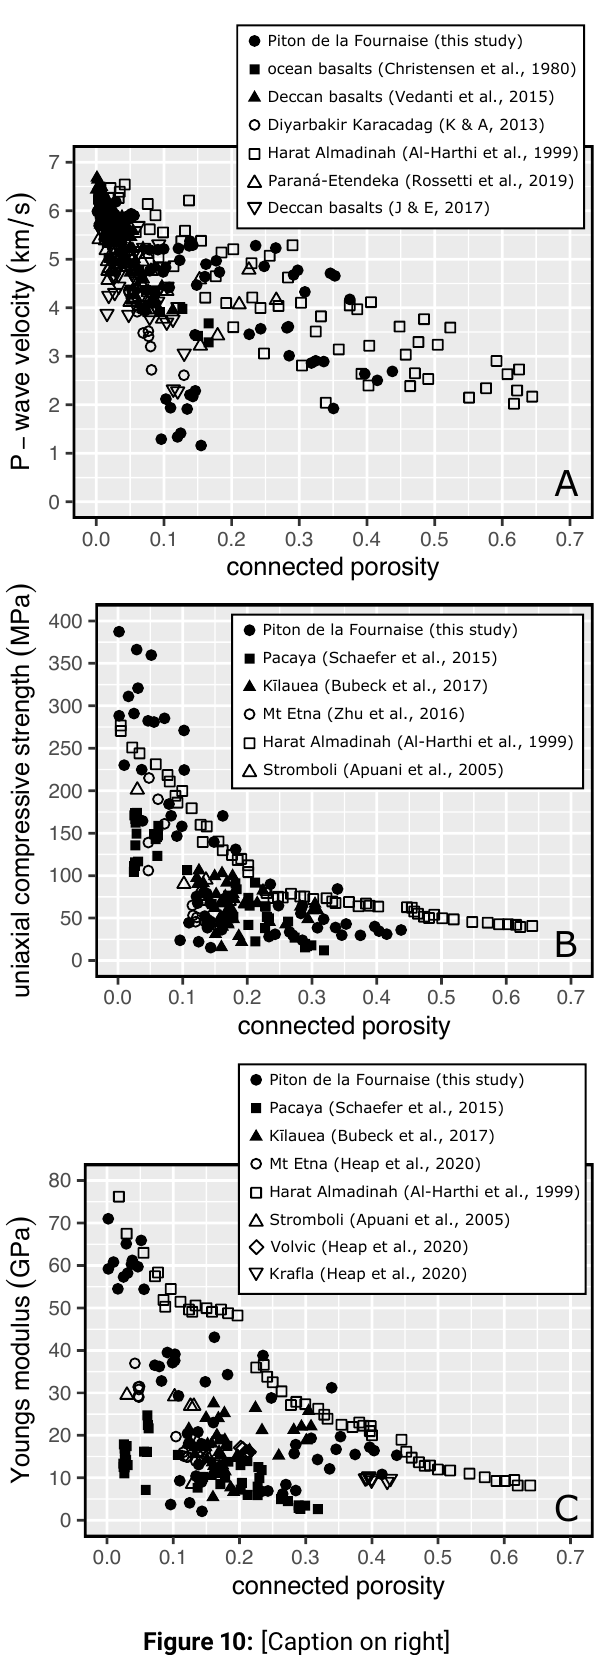
tic rocks) decreases as a function of increasing poros- ity. The number density of microstructural defects (mi- crocracks, pores) increases as porosity increases, which serves to reduce material sti ff ness (Young’s modulus). The scatter in the UCS (Figure 8) and Young’s modulus (Figure 9) data reflect variations in the proportions of pores and microcracks (porosity is a simply a scalar and does not account for such geometric di ff erences) and variations in crystal content, both of which are known to influence the strength and sti ff ness of volcanic ma- terials [e.g. Heap et al. 2016; Zorn et al. 2018; Heap et al. 2020b]. However, we highlight here that the type of phenocrysts does not seem to play a major role, as the Young’s modulus of a very olivine-rich oceanite lava is the same as the plagioclase-bearing or aphyric lavas (Table A1). Slightly altered vesicular lavas records the lowest Young’s modulus (<10 GPa) in the high porosity rocks. We compare our new P-wave velocity, UCS, and Young’s modulus data for PdF with previously pub- lished data for basalts in Figure 10. The published values for basalt are in general agreement with our new data for basaltic rocks from PdF (Figure 10). Of note, the micro-gabbro samples have a P-wave veloc- ity much lower than other samples of the same poros- ity and do not follow the general trend of decreas- ing P-wave velocity as a function of increasing poros- ity defined by the compiled data (Figure 10). A low P-wave velocity for low-porosity rocks is likely the con- sequence of a high microcrack number density,